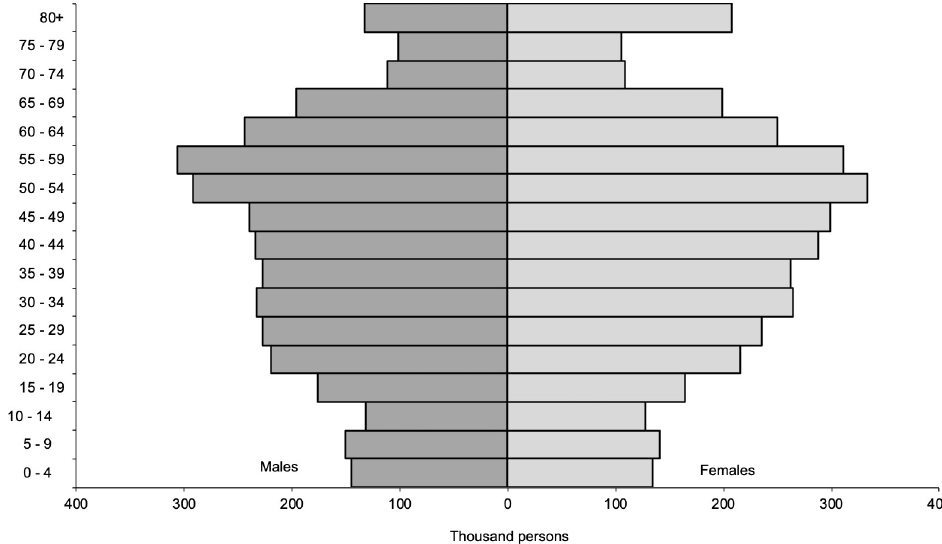
Fig 5. Population pyramid of Hong Kong, 2016. Data Source: 2016 Population By-census Office, Census and Statistics Department.